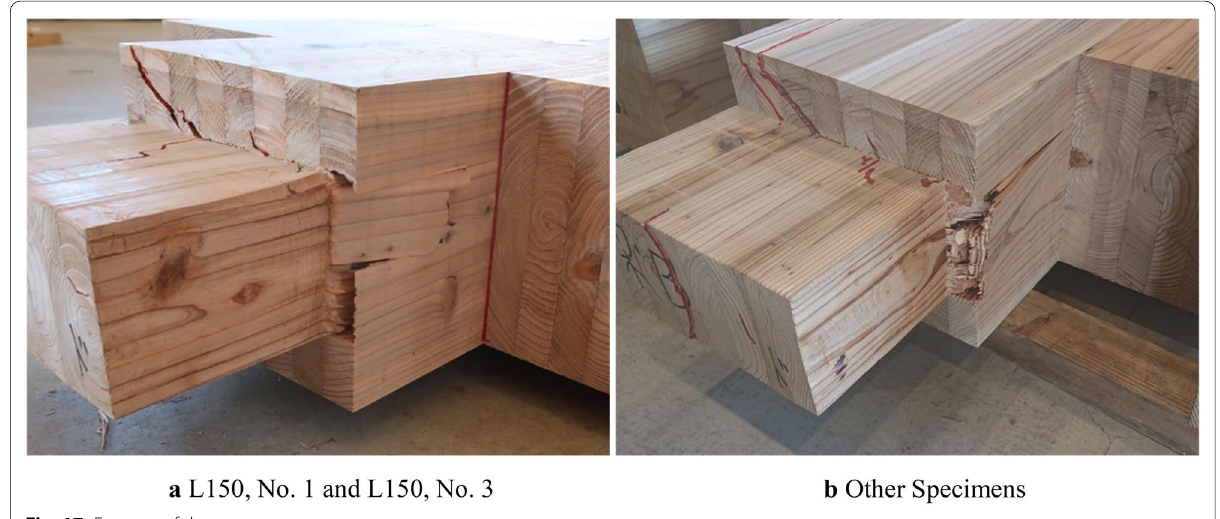
Fig. 17 Fracture of the